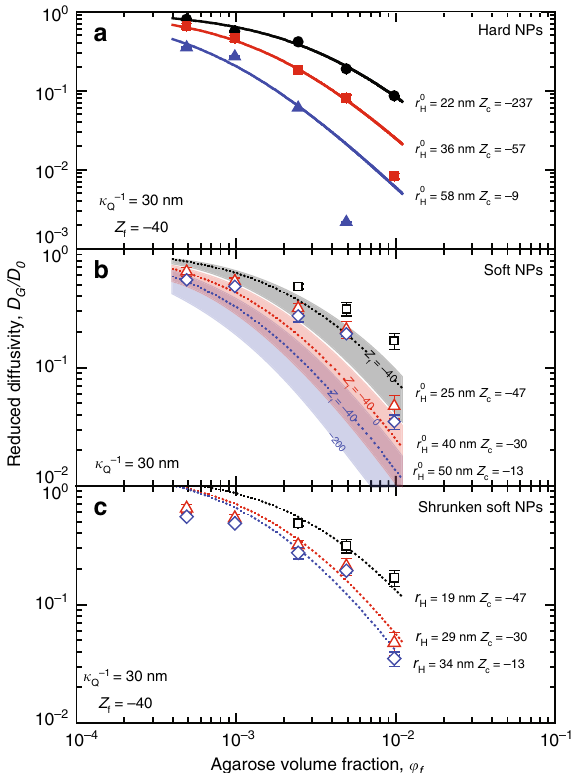
Fig. 3 Experimental reduced diffusivities and theoretical prediction using Kang et al . model. a Data for hard NPs; b Reduced diffusivity of soft NPs. The theoretical curves were produced considering no change in particle size ( r H = r 0 H ). Also presented are different simulated curves, using Eq. (4), fallen into the highlighted areas calculated for different values of Z f to demonstrate that electrostatic interactions alone cannot account for the increased diffusivity of soft NPs. c Reduced diffusivity of soft NPs (dotted lines) calculated assuming r H = α r 0 H . Data points and their error bars correspond to the average of 5 – 7 DDM measurements on one sample and their standard